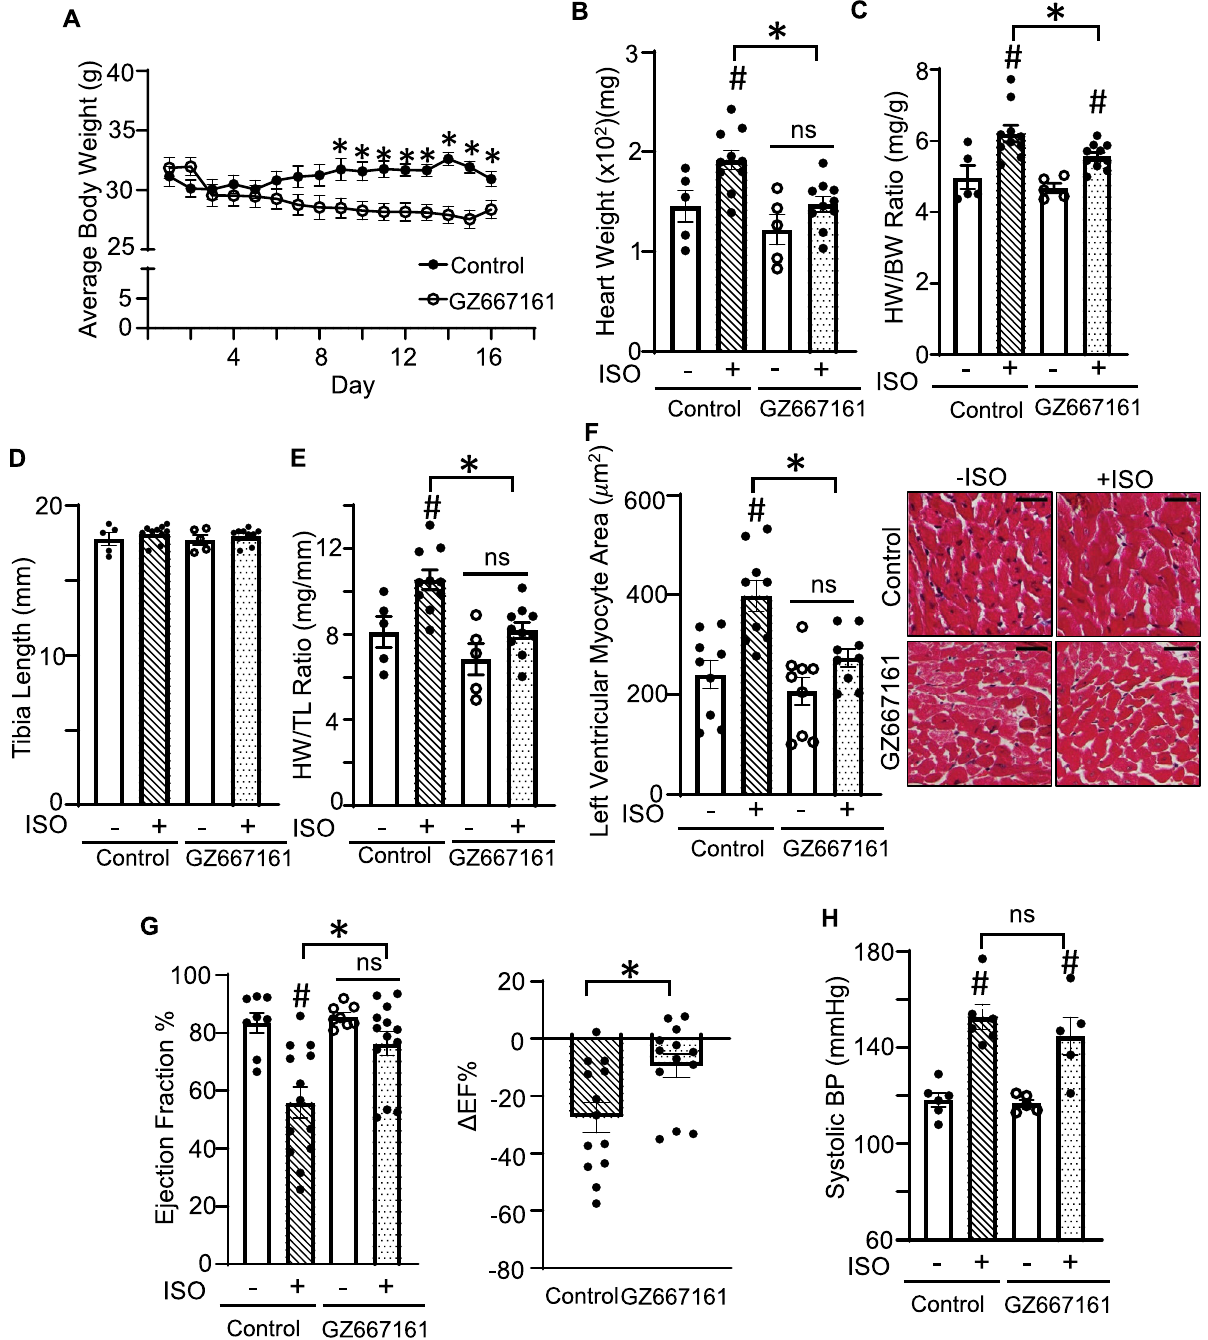
Figure 3. GZ667161 compound ameliorates ISO-induced cardiac remodeling. ( A ) Time course of average body weight of ISO treated mice (n = 10 per group) fed with control or GZ667161 diet. ( B, C ) Heart weight ( B ) and HW/BW ratio ( C ) in control or GZ667161 diet with or without ISO. − ISO (n = 5 per group). + ISO (n = 10 per group). ( D , E ) Tibia length ( D ) and HW/TL ratio ( E ) in control or GZ667161 diet with or without ISO. ( F ) Left ventricular myocyte area. ( G ) Ejection fraction and difference in ejection fraction and change in ejection fraction percentage as compared to average control for respective groups. − ISO (n = 8 per group), + ISO (n = 13 per group). ( H ) Systolic blood pressure of the mice. Data is expressed as mean ± SEM. # P < 0.05 − ISO versus + ISO. * P < 0.05 between indicated groups. ns, not significantly different between indicated